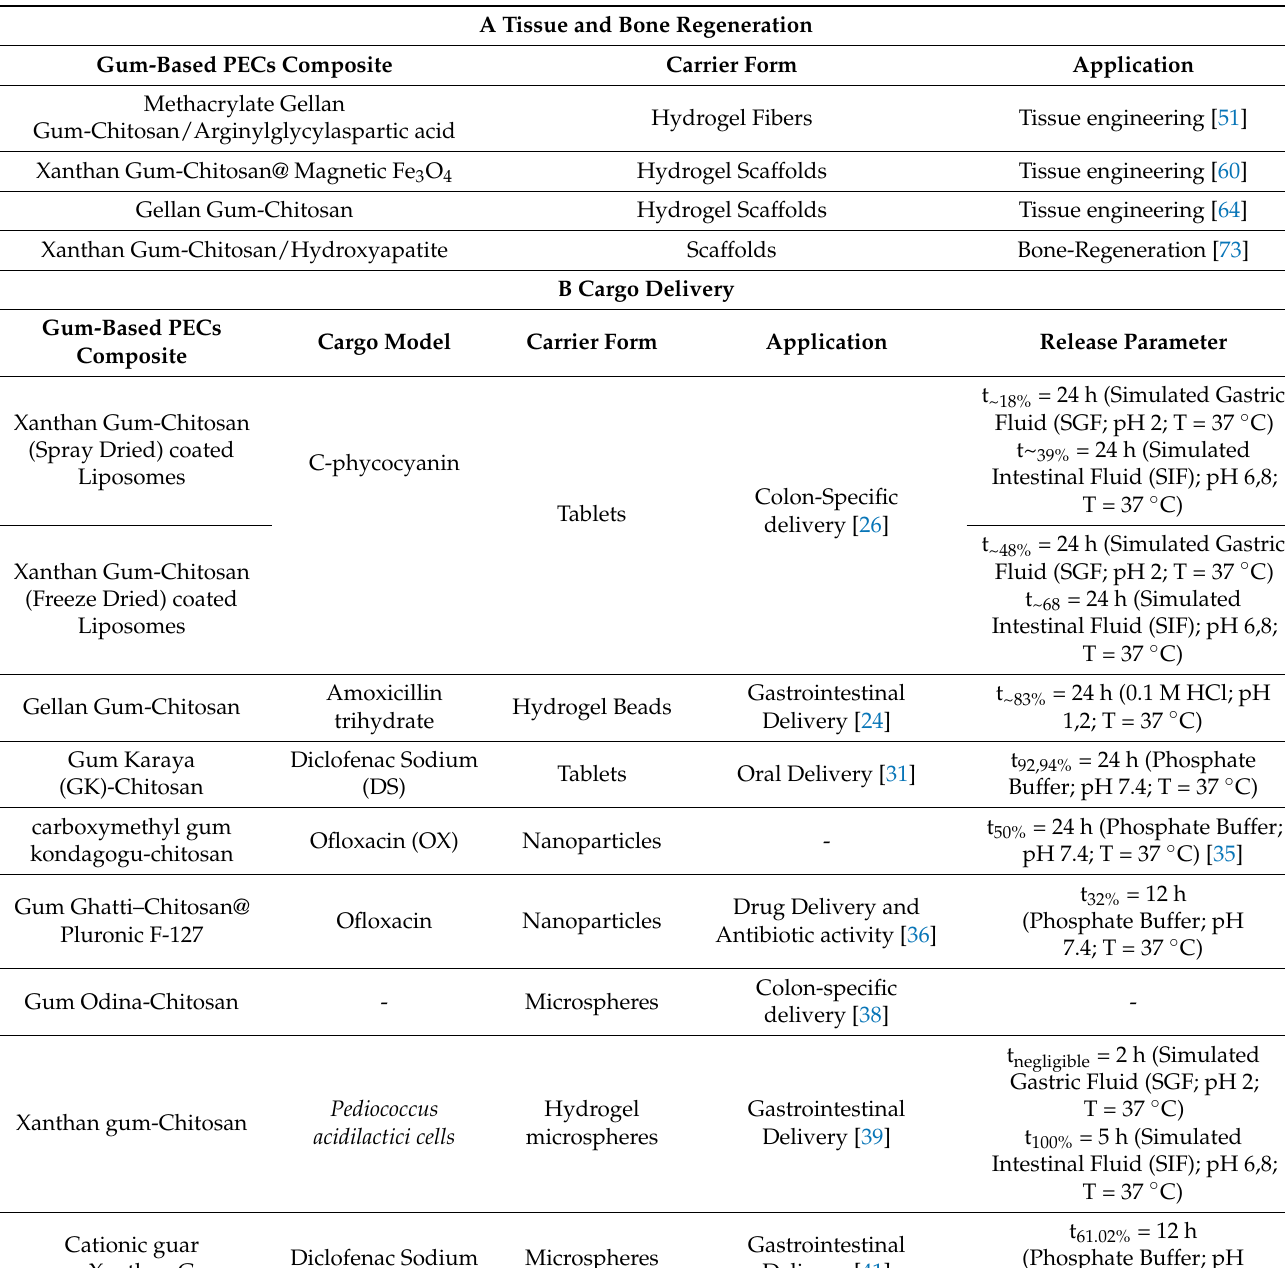
Table 2. Gum-based PECs for biomedical application for: (A) Tissue and bone regeneration; and (B) Cargo delivery. A Tissue and Bone